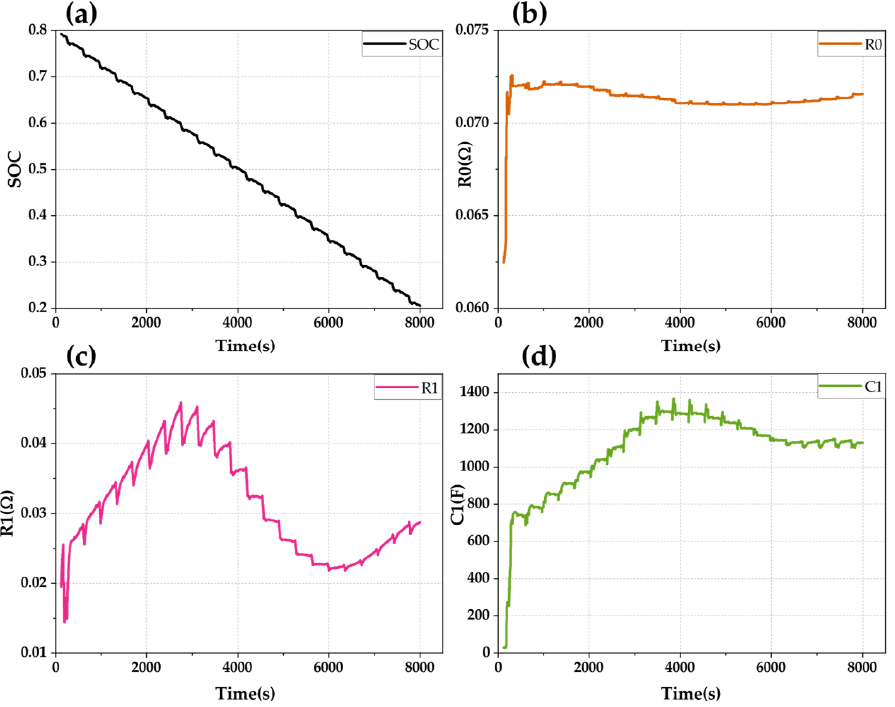
Figure 4. Changes in parameters and SOC: ( a ) the change in SOC; ( b ) the change in internal resistance R 0 ; ( c ) the change in polarization R 1 ; ( d ) the change in polarization capacitor C 1 .